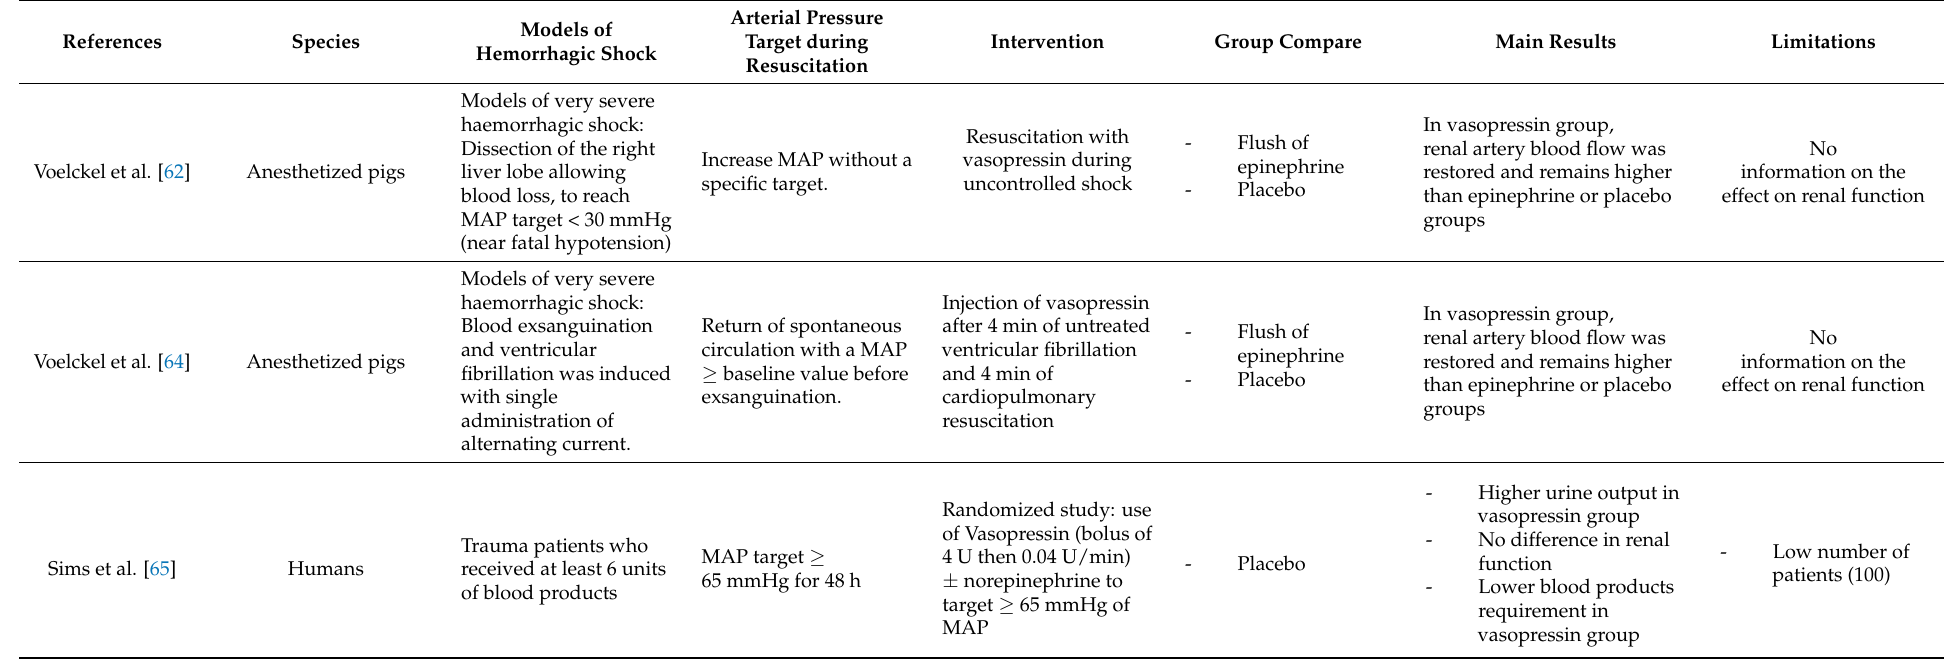
Table 2. Vasopressin and kidney during hemorrhagic shock. MAP: mean arterial